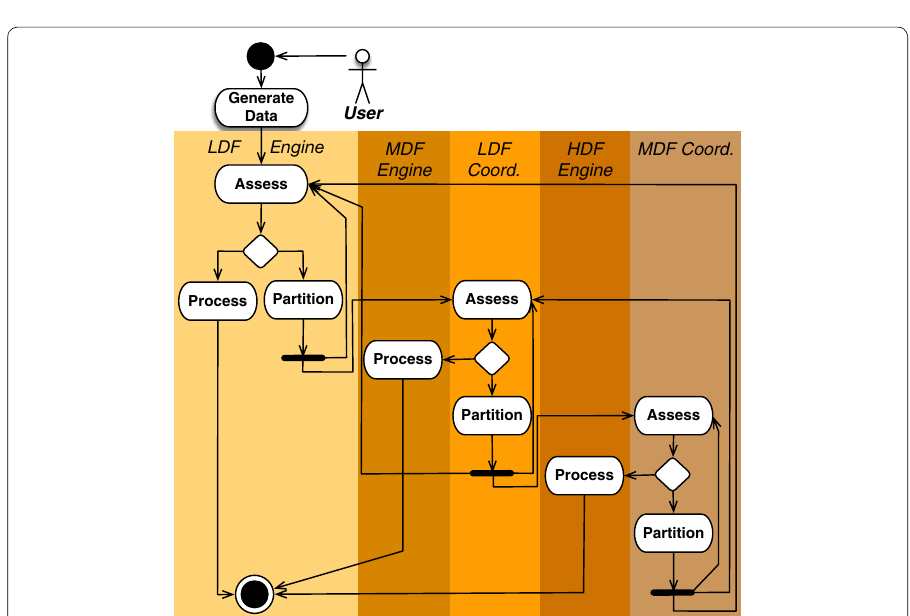
Fig. 3 IoT hierarchical data fusion workflow. This figure depicts the general data fusion workflow where data generated at a low level is processed and transformed as it is pushed upwards through the